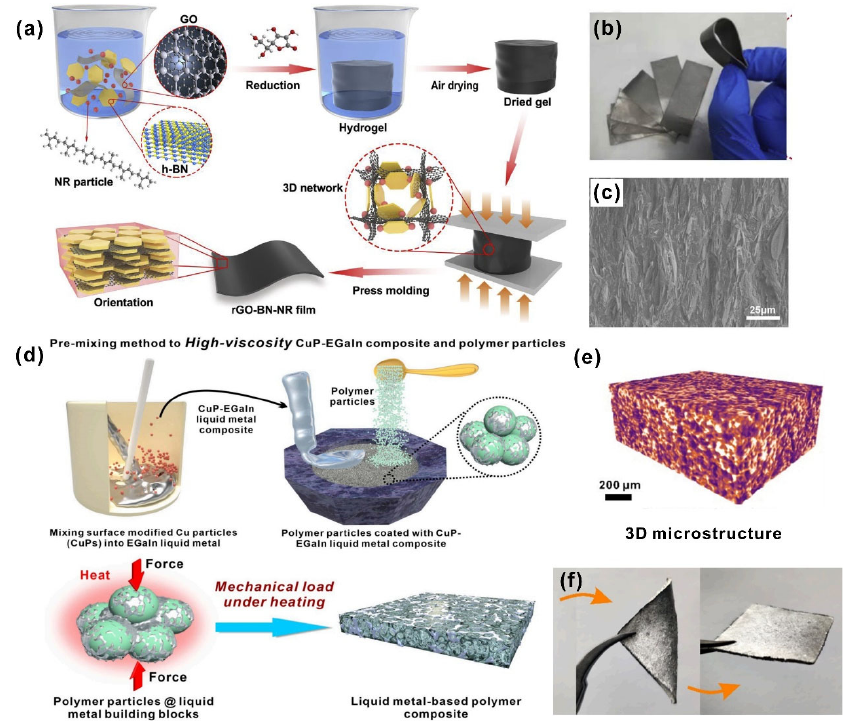
Figure 7. ( a ) The schematic of the fabricating procedure for the rGO–BN–rubber composite. ( b ) The photograph of the obtained films. ( c ) The SEM image of the obtained films under pressure (( a – c ) reprinted/adapted with permission from Ref. [102]. 2020, Elsevier). ( d ) Schematic illustration of the hybrid filler (pre-mixed copper and liquid metal) flowing to fill the gaps between TPE particles under pressure load during heating. ( e ) The 3D microstructure network of liquid metals as produced by a microcomputed tomography (Micro-CT) experiment. ( f ) The optical images of liquid-metal- based TPE composite (bending and after bending) (( d – f ) reprinted/adapted with permission from Ref. [92]. 2022,